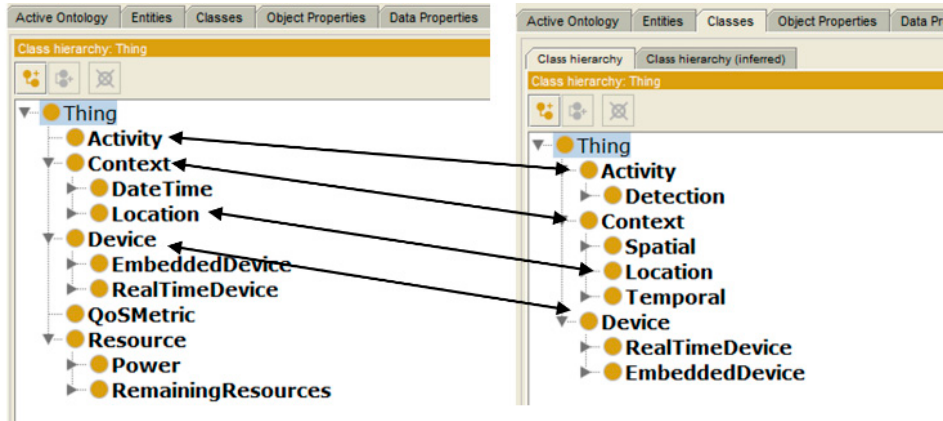
Figure 2. Context and mobile robot ontologies mapping.